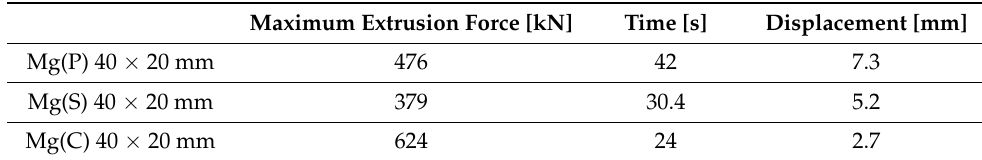
Table 1. Time and displacement parameters for maximum extrusion force during KOBO extrusion of magnesium raw